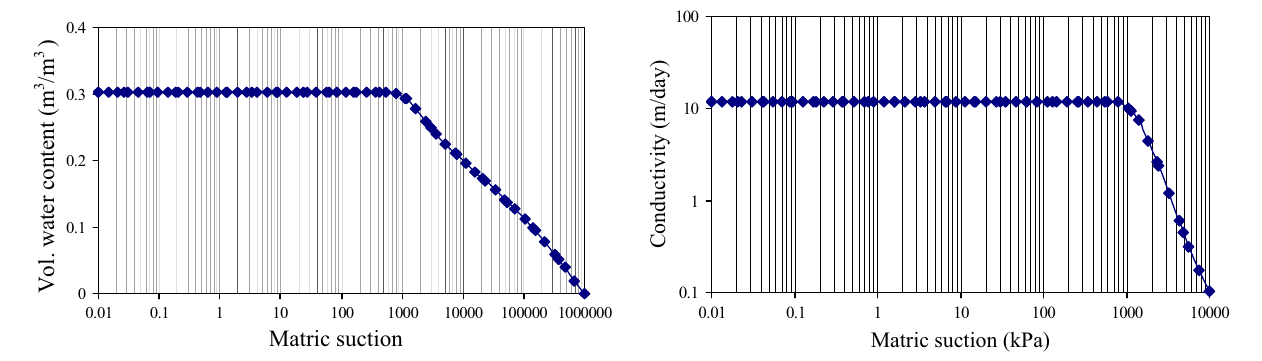
Loading stage ( elastic - plastic model )